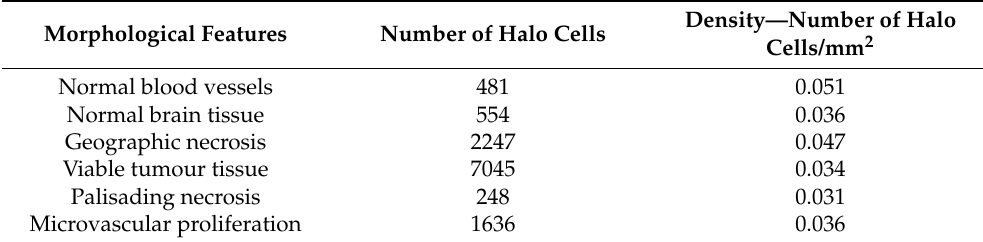
Table 3. Density of “halo cells” in relation to diagnostic morphological features in adjacent H&E- stained